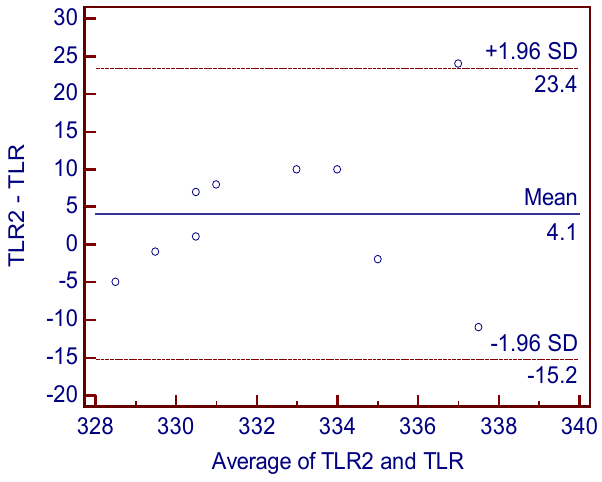
Figure 2 . A Bland-Altman plot is shown. The x-axis shows the average of pairs of measurements while the y-axis shows the difference between pairs of measurements. The mean difference between the two sets of data (MD) is shown by the solid line while the 95% LOA are shown by dotted